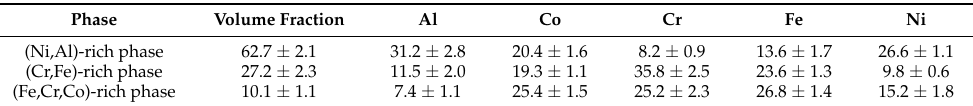
Figure 2. SEM-BSE images of the X 0 as-cast alloy: ( a ) low magnification; ( b ) high magnification of dendrite; and ( c ) high magnification of interdendrite. Table 2. Chemical composition (at.%) and volume fraction (%) of the interior phases marked in Figure